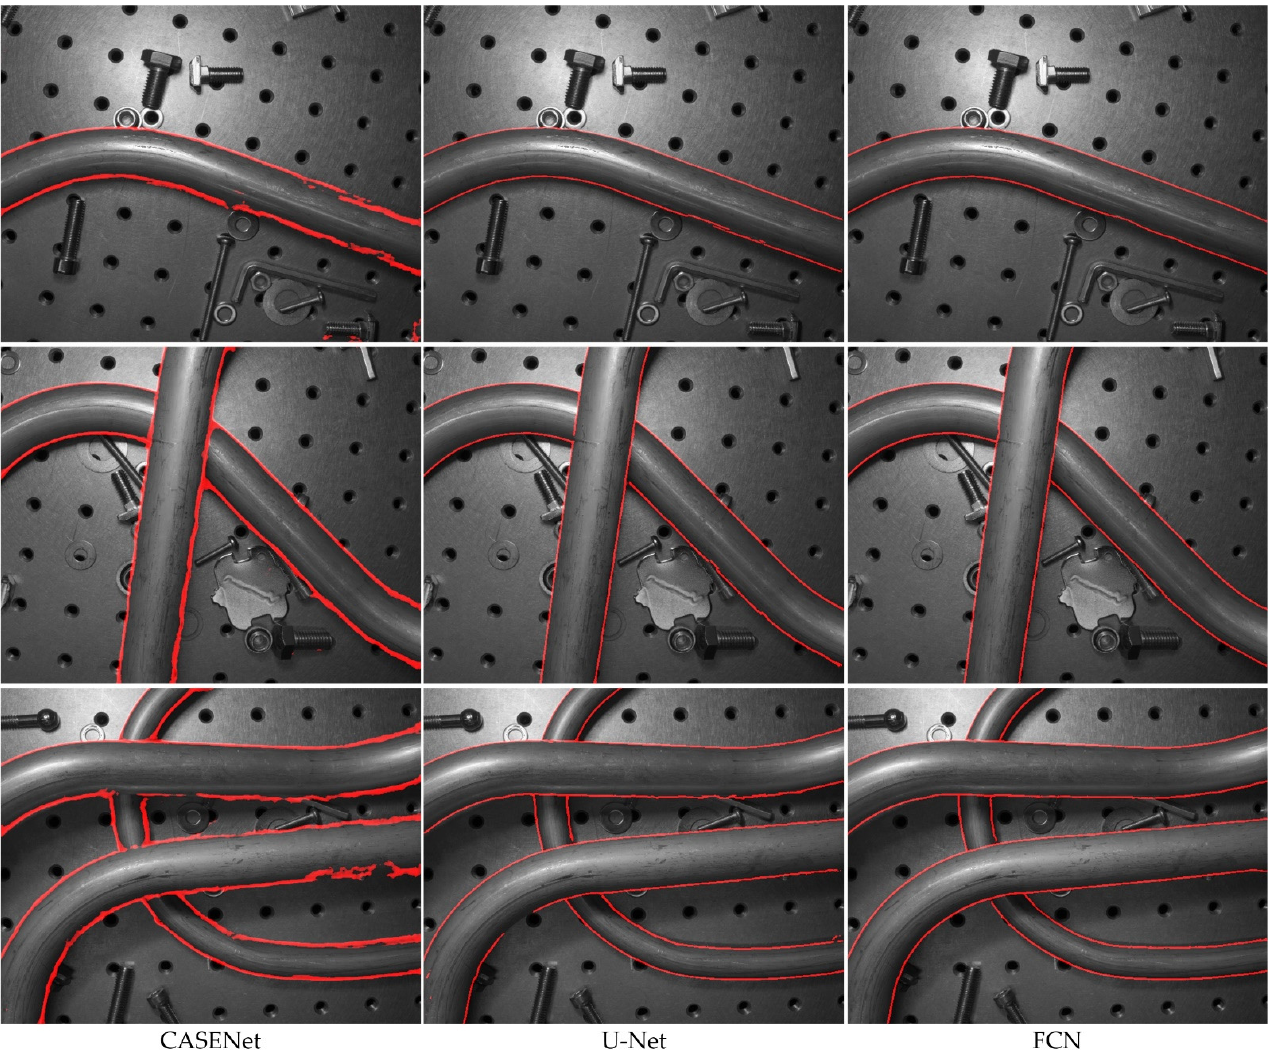
Figure 16. Tube contour detection results of comparing methods on the METCD. The images in the left column were produced by the CASENet model, in the middle column were produced by the original U-Net model and in the right column were produced by our FCN model.